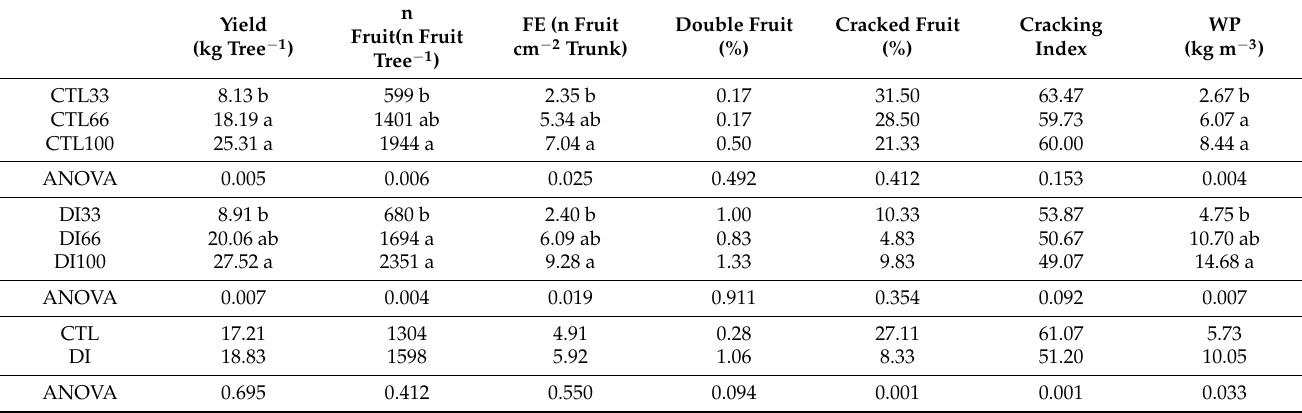
Table 1. Yield, number of fruits per tree, fruit efficiency (FE), double fruit, cracked fruit at harvest, cracking index, and water productivity (WP) of ‘Prime Giant’ sweet cherries under two irrigation treatments, control (CTL), and deficit irrigation (DI) and three levels of crop load (high—100%, medium—66%,